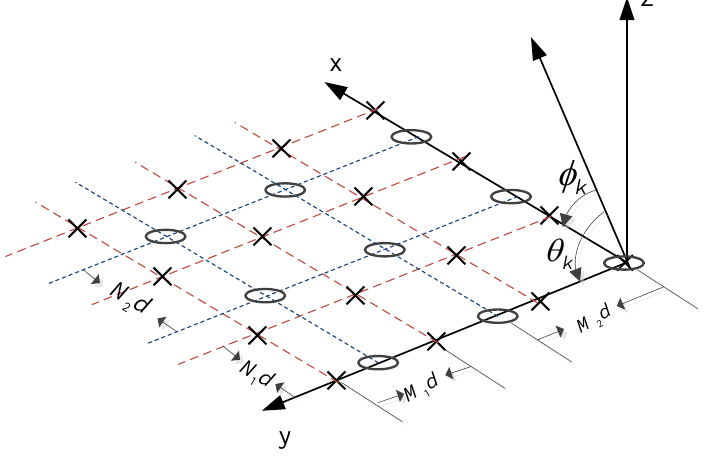
Figure 1. System model of the considered generalized coprime planar array, where d = λ